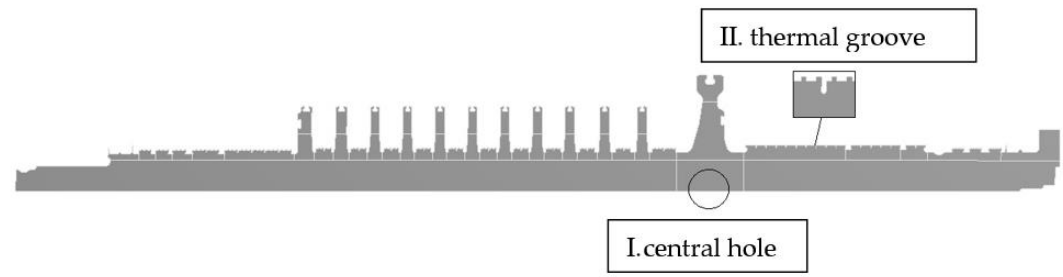
Figure 1. Critical areas of a steam turbine rotor.